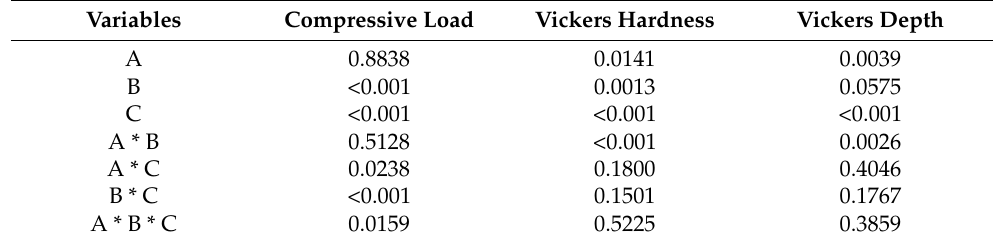
Table 4. ANOVA p-values showing the effect of the main studied factors and their interactions on the mechanical properties of the